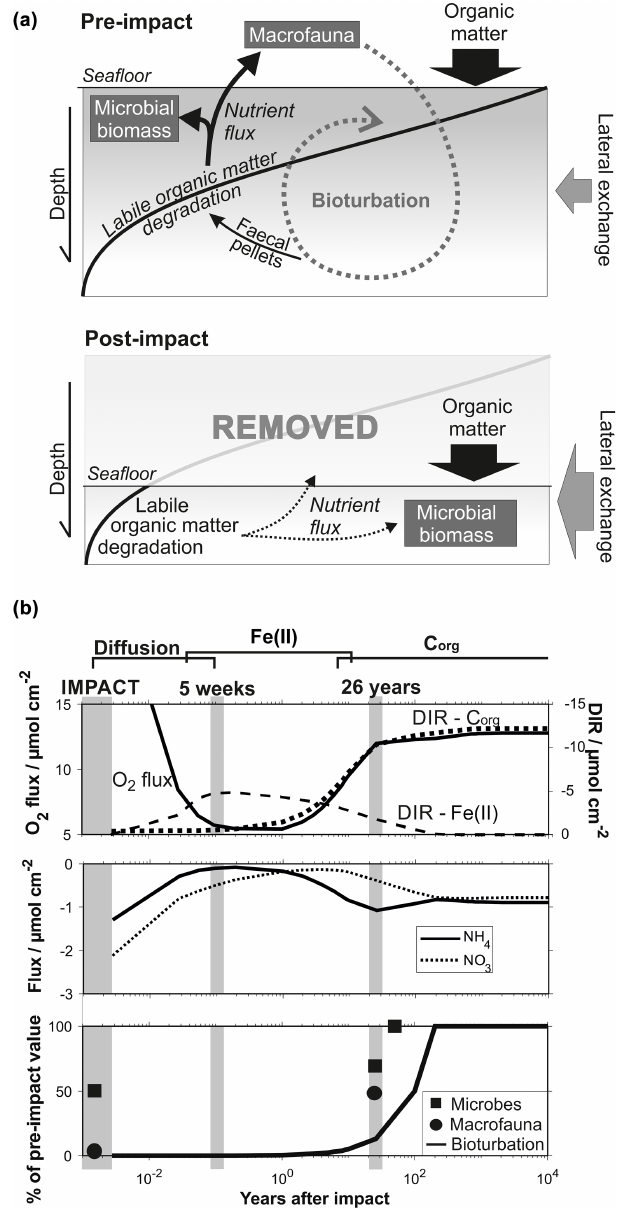
Figure 12. (a) Schematic diagram showing the delicate interplay between the distribution of organic matter, microbial activity and the bioturbation through burrowing megafauna in a pre-impact system and after removal of the upper reactive sediment layer. (b) Quantitative comparison of geochemical and biological pro- cesses over time after an impact through sediment removal. Bio- logical data are taken from Stratmann et al. (2018a; macrofaunal abundance) and Vonnahme et al. (2020; microbial cell count) for the most severely disturbed sites (e.g. inside 5-week-old EBS tracks and inside 26-year-old plough